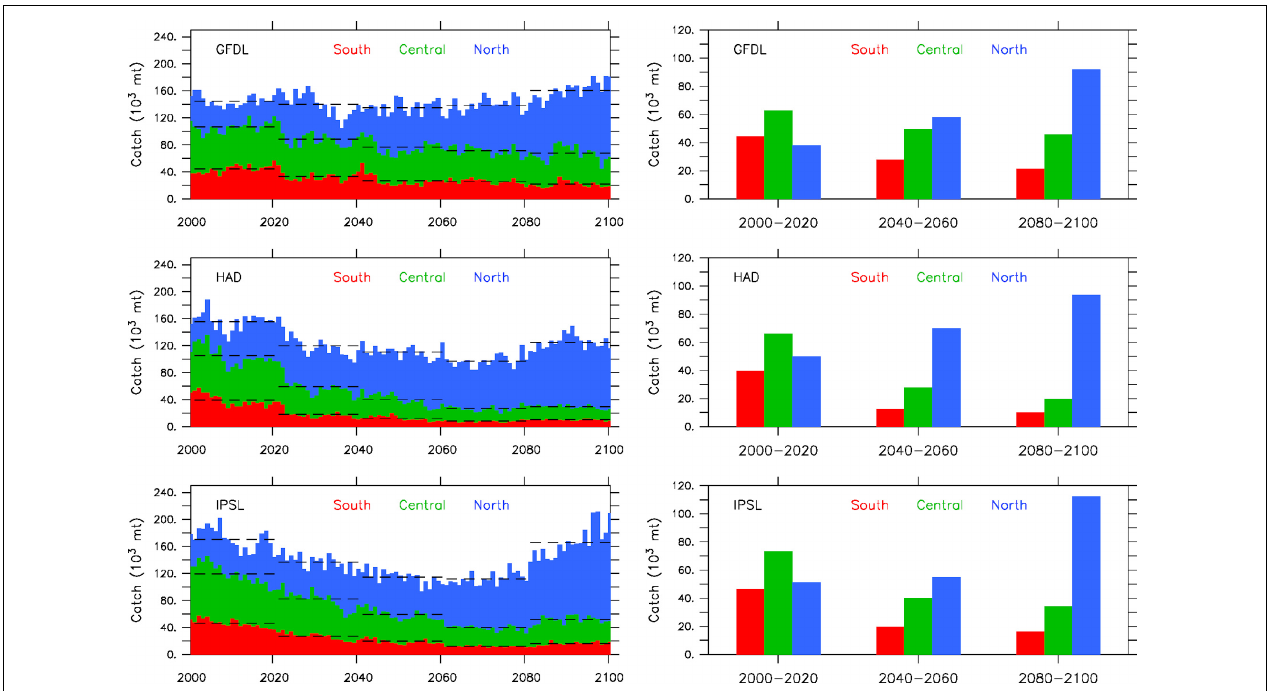
FIGURE 6 | Projected sardine catch (10 3 metric tons) for 2000–2100 in southern (red), central (green) and northern (blue) CCS from GFDL (top) , Hadley (middle) , and IPSL (bottom) solutions. Left: cumulative annual catch (bars) and 20-year averages (dashed lines). Right: 20-year average catch by region during 2000–2020, 2040–2060, 2080–2100. The three subregions correspond to catch originating from Long Beach (southern CCS), Monterey (central CCS) and Astoria + Westport (northern